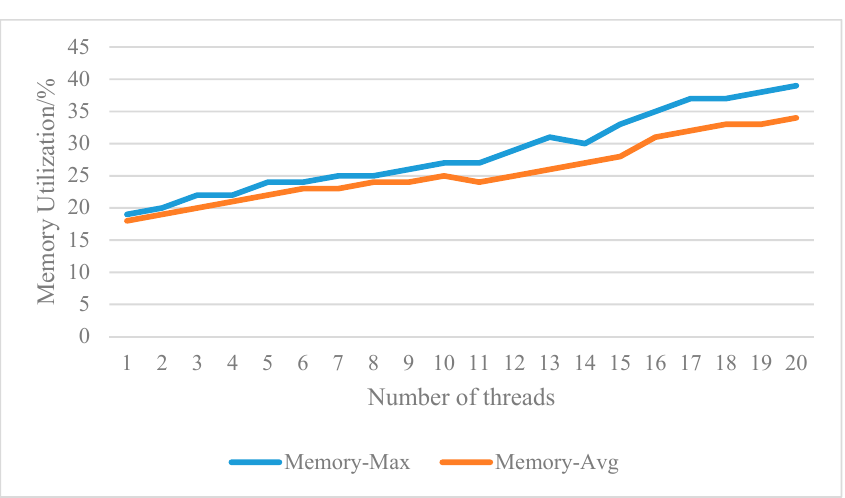
Figure 14. Memory utilization (%).